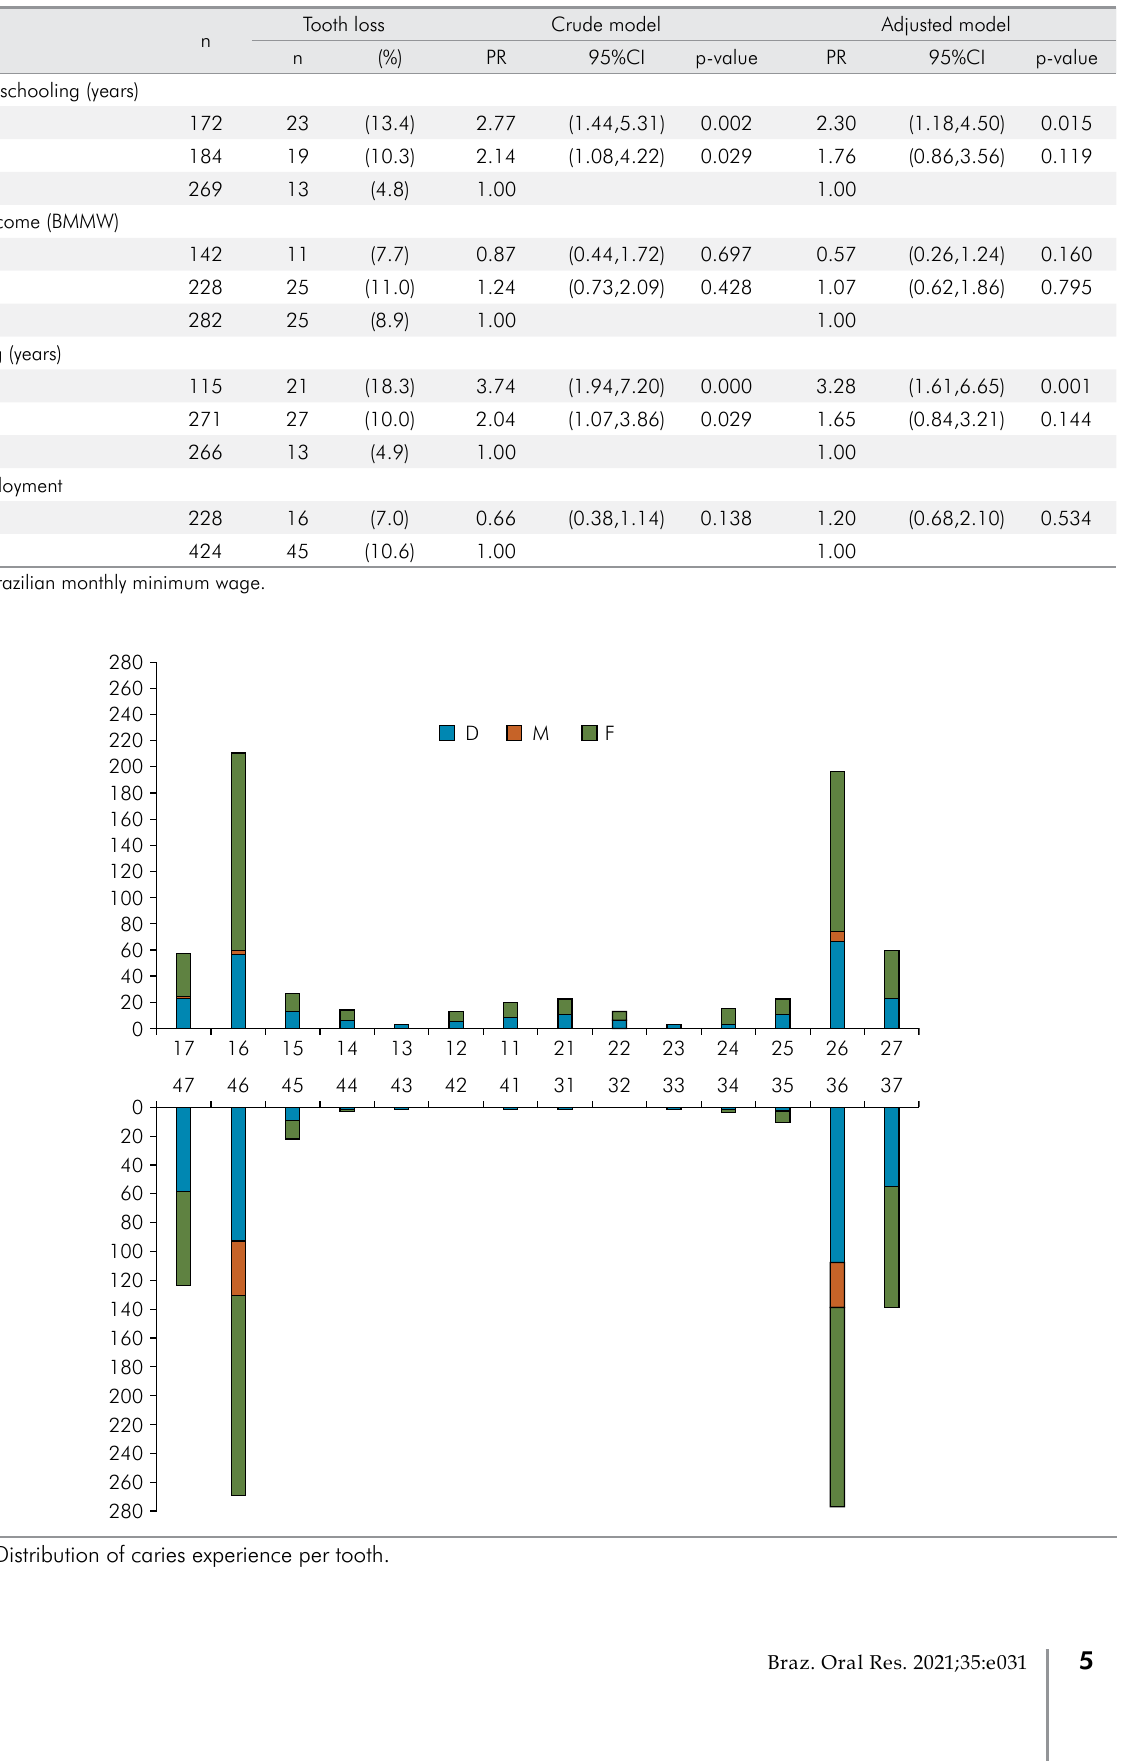
Table 2. Prevalence, crude and adjusted prevalence ratios (PR) and 95% confidence intervals for tooth loss in male adolescents from southern Brazil.